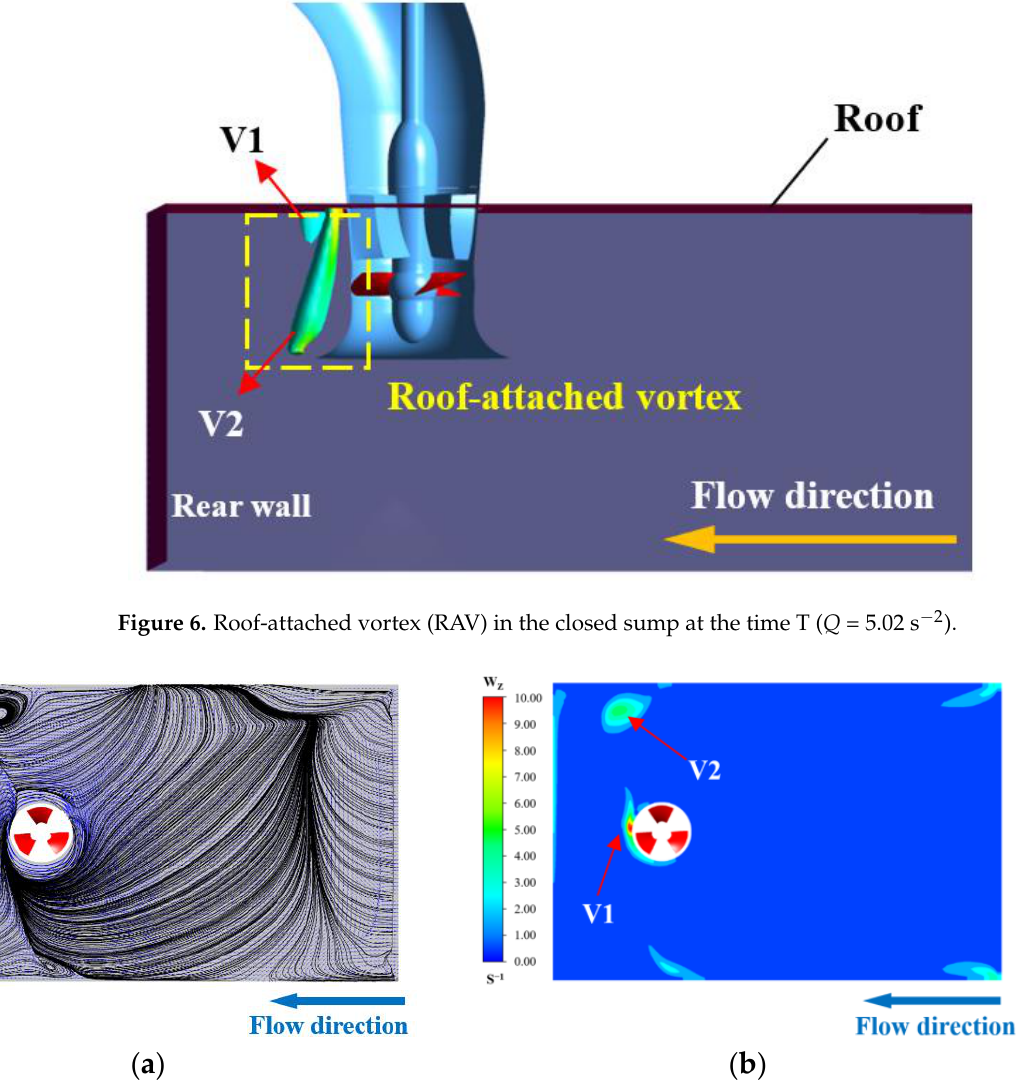
Figure 7. Streamline and vorticity intensity distribution near the roof at time T. ( a ) Streamline. ( b ) Vorticity.